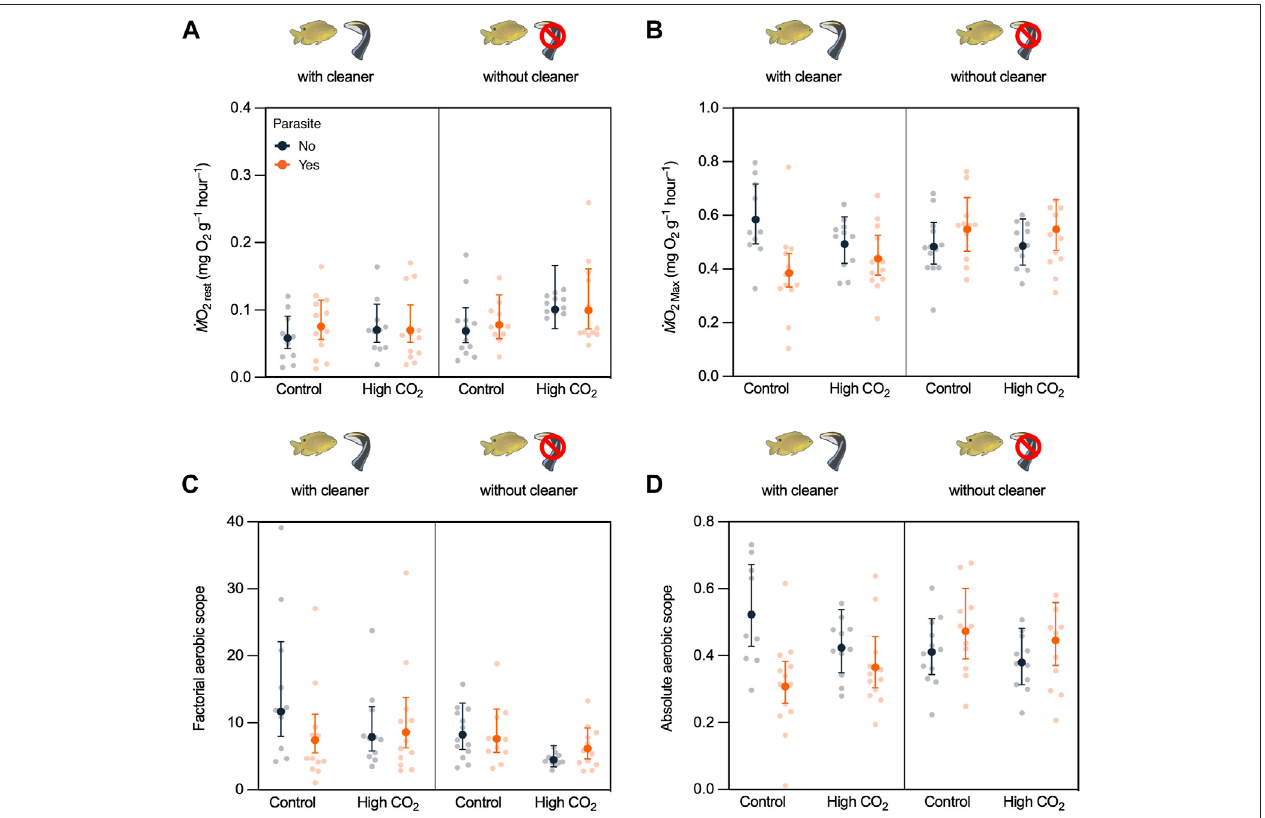
FIGURE 3 | Damsel fi sh Pomacentrus amboinensis aerobic physiology obtained through the exhaustive chase protocol according to CO 2 treatment (Control vs. High CO 2 ), cleaner wrasse removal treatment (with cleaner vs . without cleaner), and parasite infection (Yes vs. No). (A) resting metabolic rate ( ˙ M O 2Res , (B) maximum metabolic rate ( ˙ M O 2Max ), (C) factorial aerobic scope (FAS), and (D) absolute aerobic scope (AAS). Back-transformed predicted means ±95% con fi dence intervals (C.I.) from the model and raw data values are presented.